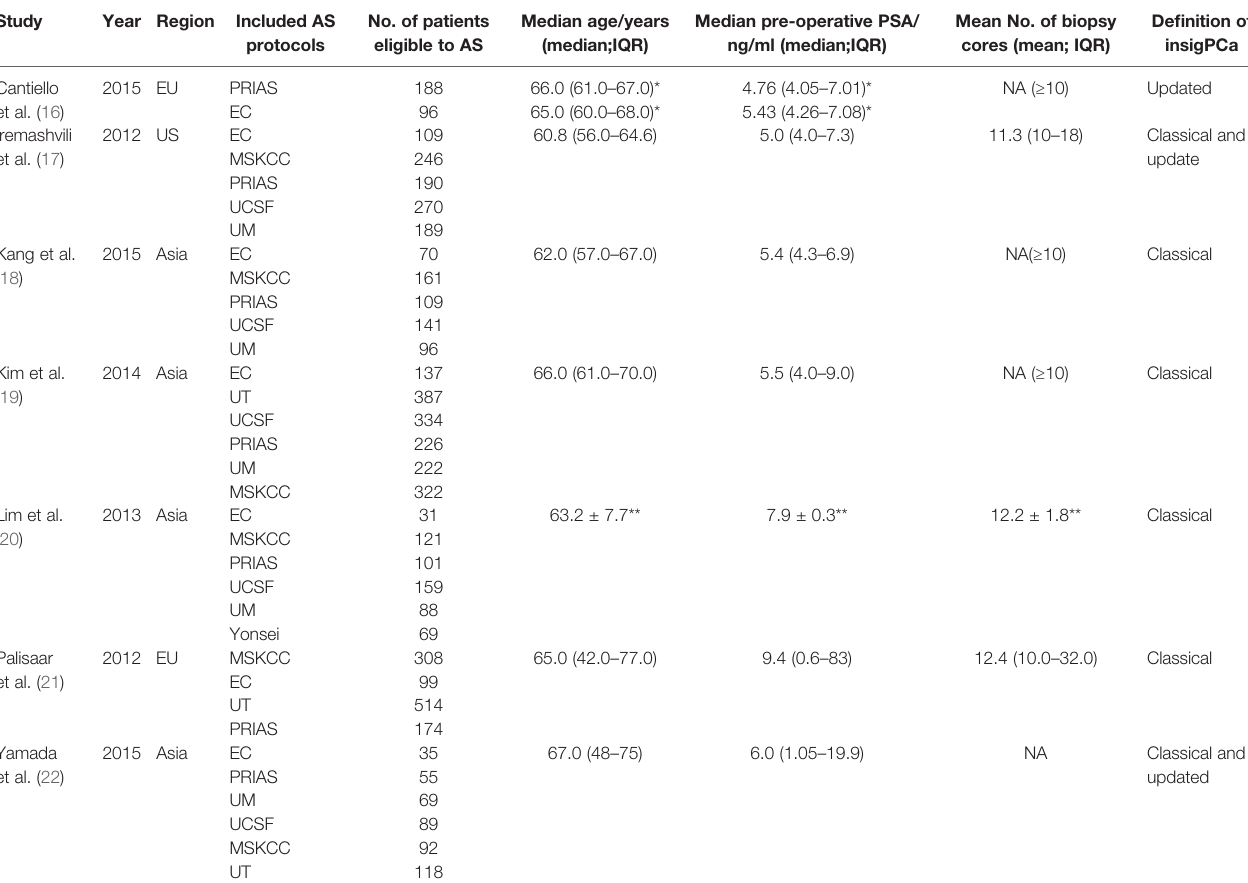
TABLE 1 | Baseline characteristics of studies eligible for the network